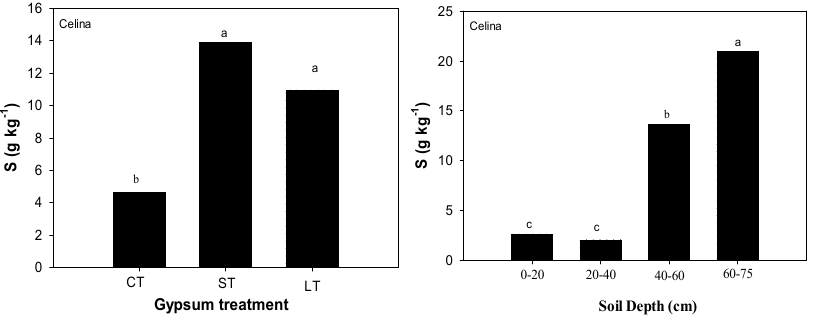
Figure 2. Sulphur mean values of Celina soils for each gypsum treatment ( left ) and in each soil layer ( right ). Means followed by the same letter or no letters for each soil and soil layer are not significantly different by Tukey’s test at p < 0.05 .